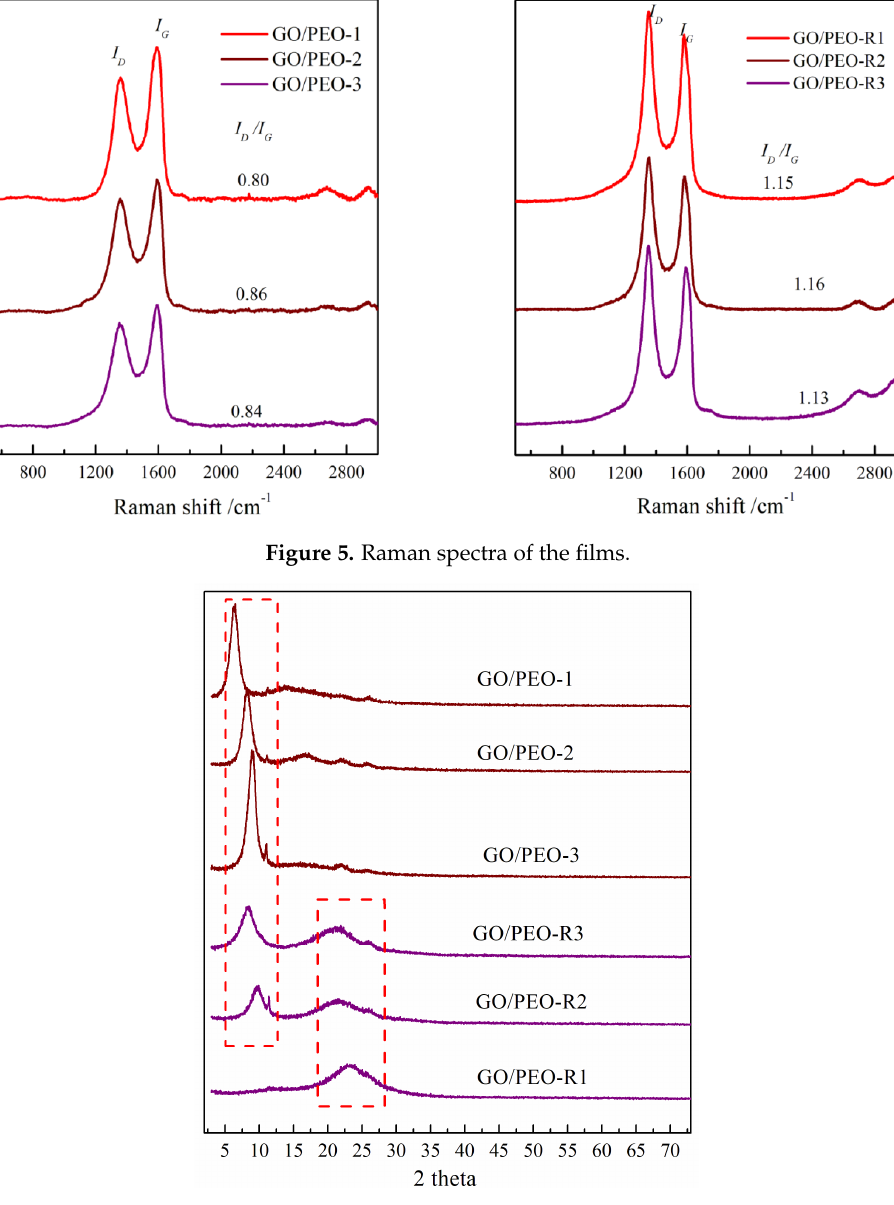
Figure 6. XRD patterns of the films.